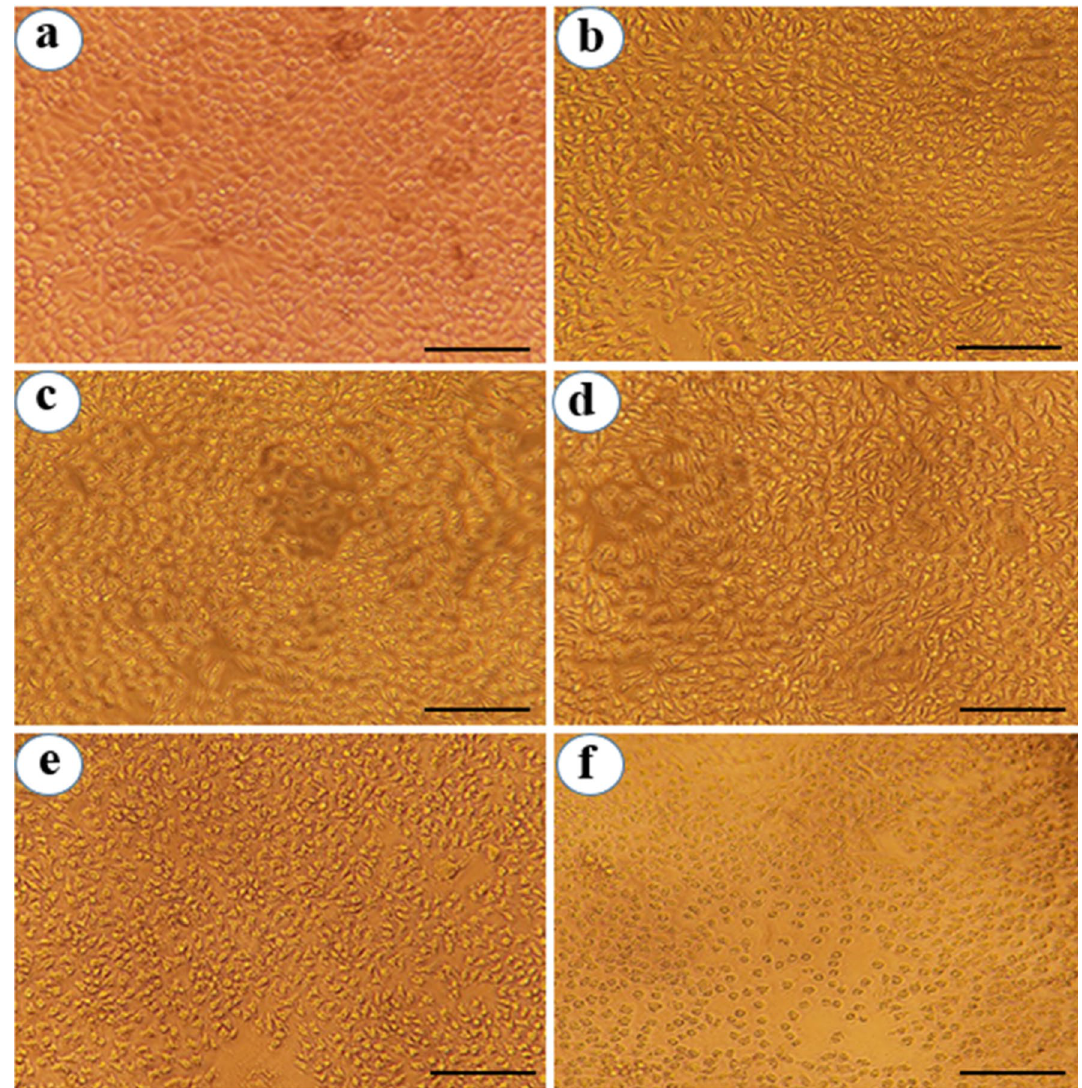
Figure 10. Cytotoxic activity of the different concentrations of the extract of Perilla frutescens on MCF-7 cells. ( a ) Untreated cells, ( b ) 37.5 µg/mL, ( c ) 75 µg/mL, ( d ) 150 µg/mL, ( e ) 300 µg/mL, ( f ) 600 µg/mL of the extract of P. frutescens . (Scale bars represent 200